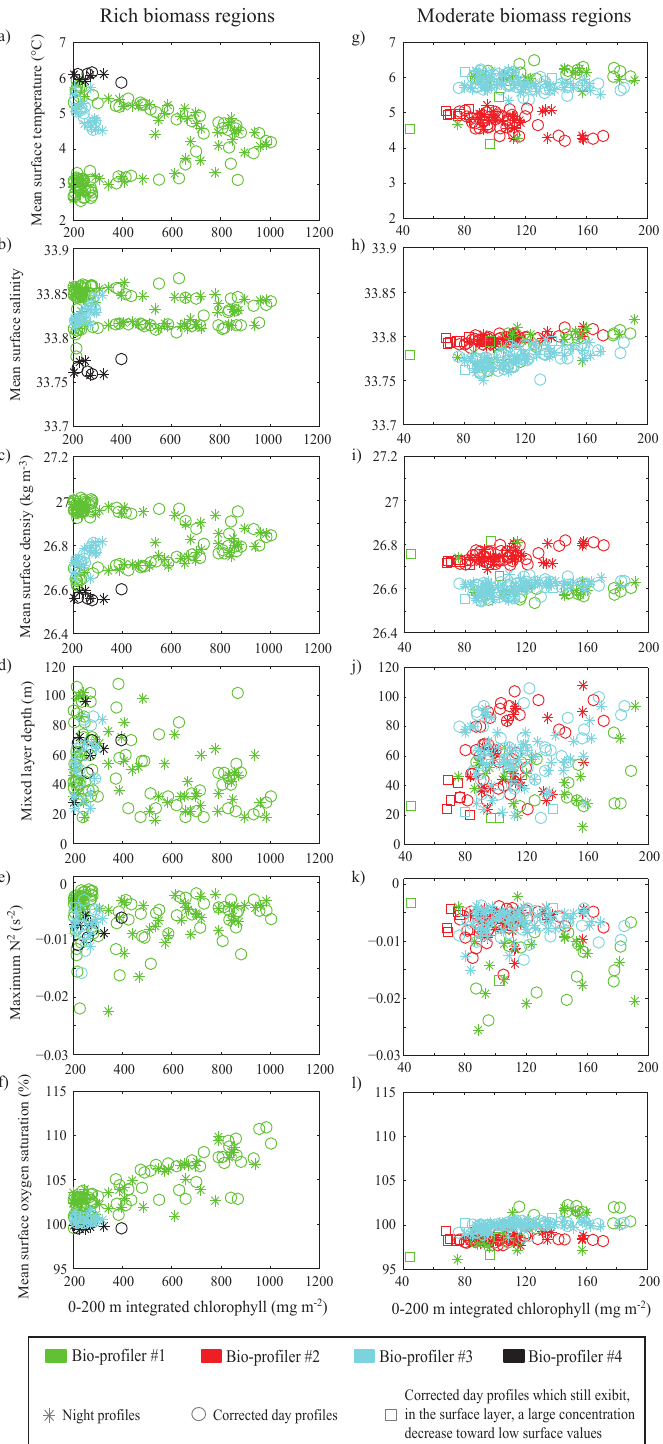
Figure 10. Relationship between 0–200m integrated chlorophyll a concentration and various water properties for (a–f) high-biomass regions close to the plateau (bio-profilers #1 and #3) or entrapped in eddies (bio-profilers #2 and #4; red rectangles in Figs. 3, 4, 5, and 6) and (g–l) moderate-biomass regions far from the plateau (yellow rectangles in Figs. 3, 4, 5 and 6). (a, g) Surface temperature (in ◦ C), (b, h) surface salinity (unitless), (c, i) surface density (in kgm − 3 ) , (d, j) mixed layer depth (MLD; in m), (e, k) maximum Brunt–Väisälä frequency squared ( N 2 ; in s − 2 ) , and (f, l) oxygen saturation state (in %). Symbols and colours are defined in the